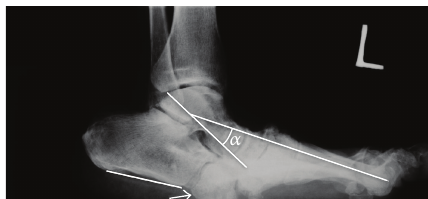
Figure 2: Lateral X-ray image of the weight bearing left foot, visible negative inclination of calcaneus (white line), and collapse of middle part of tarsus (angle 𝛼 ) with plantar prominence of cuboid bone